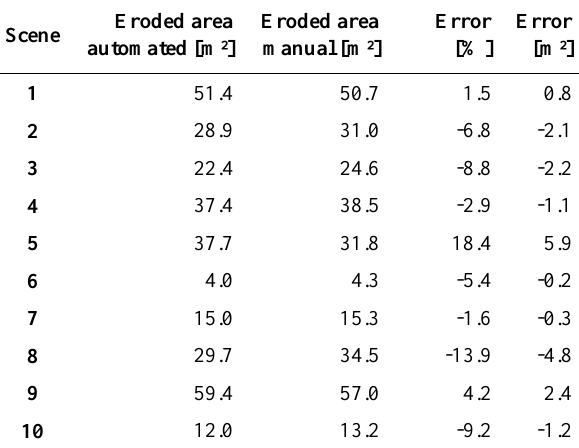
Table 2: Sizes of the eroded areas classified in the ten scenes with the automated approach and manually. The error of the automated classification is calculated as the deviation from the manual classification.